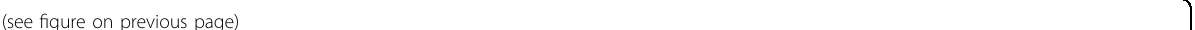
Fig. 2 Assessment of changes in B cells in transcriptional pro fi les between MG patients and healthy controls. a UMAP plot displaying 4133 B cells from two MG patients and two HCs separated into 9 subtypes. b Violin plots showing key gene markers across B cell subsets. c Gene set enrichment revealed differences in pathway activities and cell identity of naive, memory, switched B cells, and plasma B cells. d B cells were sorted using the DDRTree algorithm and projected onto the different cell states using the color in a . Transcriptional activity was estimated by measuring the ratio between unspliced and spliced mRNAs. The length of the arrow represents the transcriptional activity. e UMAP plots showing the expression of BCL3 and POU2AF1 genes in B cells (top) and the AUC of the estimated regulon activity of the corresponding TFs, predicting the degree of expression regulation of their target genes (bottom). f Heatmap of the AUC scores of expression regulation by transcription factors (regulon activity), as estimated using SCENIC, followed by comparisons between two groups using the t -test. The twenty transcription factors with the highest upregulated expression in MG are